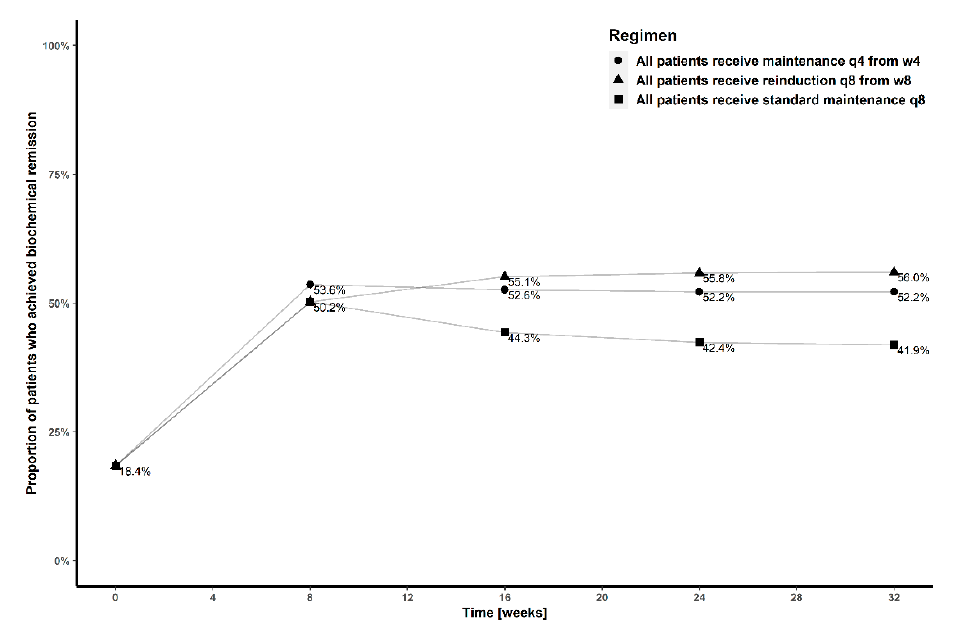
Figure 3. Proportion of patients achieving biochemical remission at weeks 8, 16, 24 and 32, with standard treatment ( ■ ), treatment with initial induction, followed by maintenance dosing every four weeks from week 4 ( ● ) and induction dosing every eight weeks ( ▲ ).